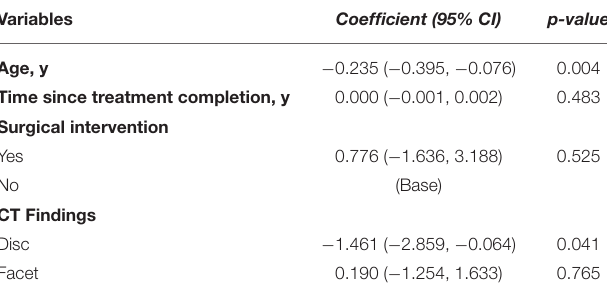
TABLE 3 | Results of the multiple linear regression analysis ( n = 116) ( F 5 = 4.62, p <